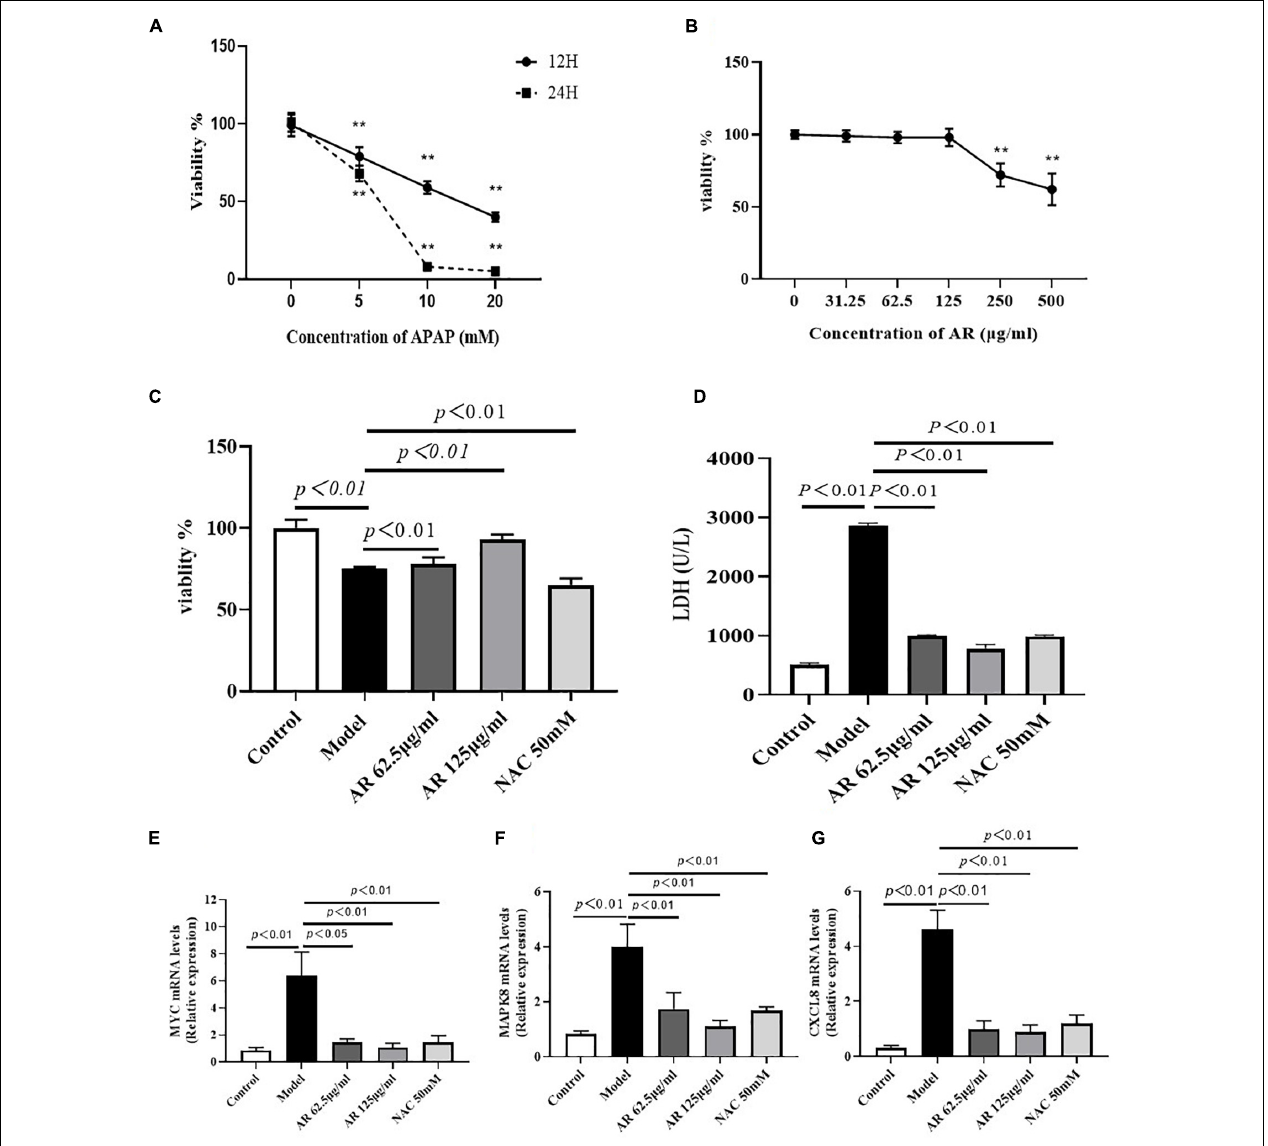
FIGURE 8 | Effect of Astragali Radix (AR) treatment on APAP induced hepatocyte injury and the expression of genes related to hepatocyte apoptosis. (A) Viability of L-02 cells at 12 and 24 h incubated with different concentrations of APAP assessed by CCK8 assay. L-02 cells were treated with APAP (20 mM) with or without AR (62.5, 125 µ g/ml) and NAC (50 mM) for 12 h. (B) Viability of L-02 cells at 12 h incubated with different concentrations of AR observed by CCK8 test. (C) Effect of AR on viability of L-02 cells. (D) The amount of LDH released into the extracellular medium of AR treatment and untreated L-02 cells. The mRNA levels of MYC (E) , MAPK8 (F) , and CXCL8 (G) in L-02 cells were